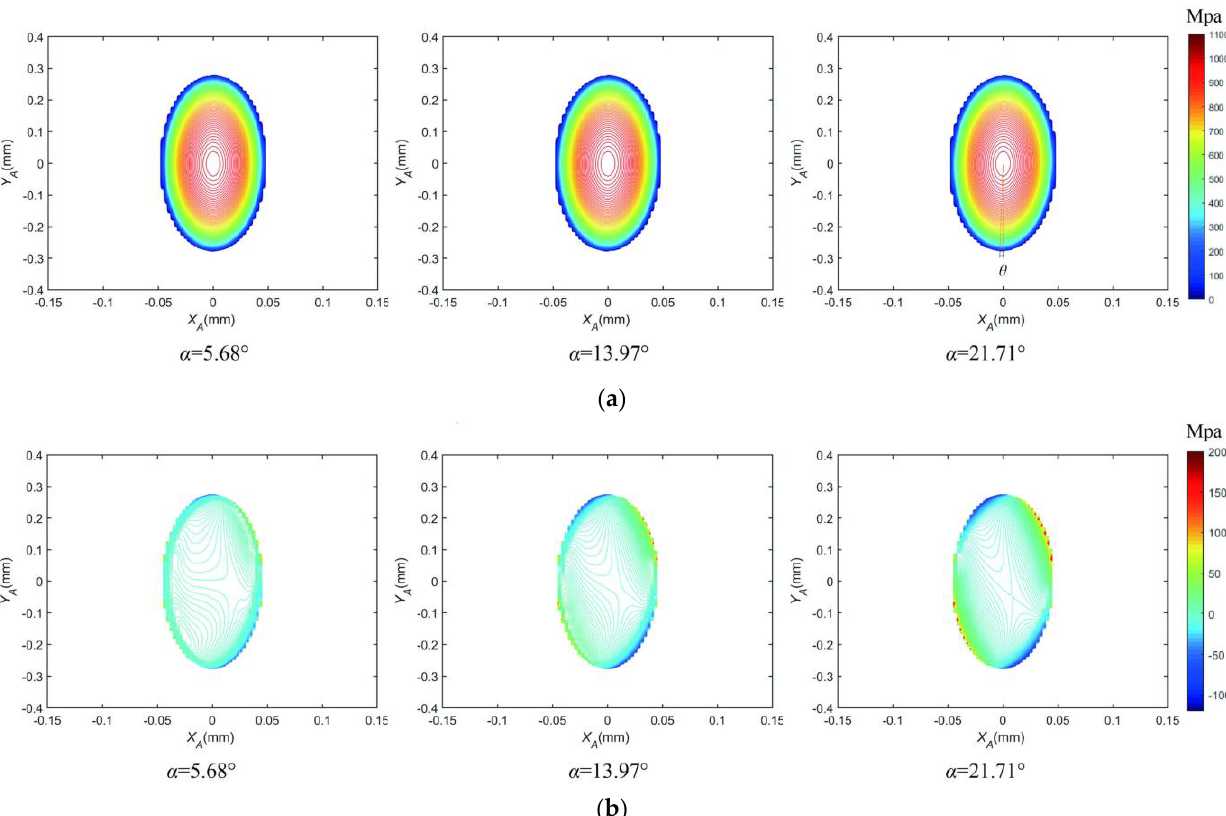
Figure 8. The variation of the non-Hertzian contact stress with different helix angles. ( a ) Contour map of non-Hertzian contact pressure distribution P A (Mpa). ( b ) Distribution difference between non-Hertzian contact pressure and Hertzian contact pressure P A - P AH (Mpa).